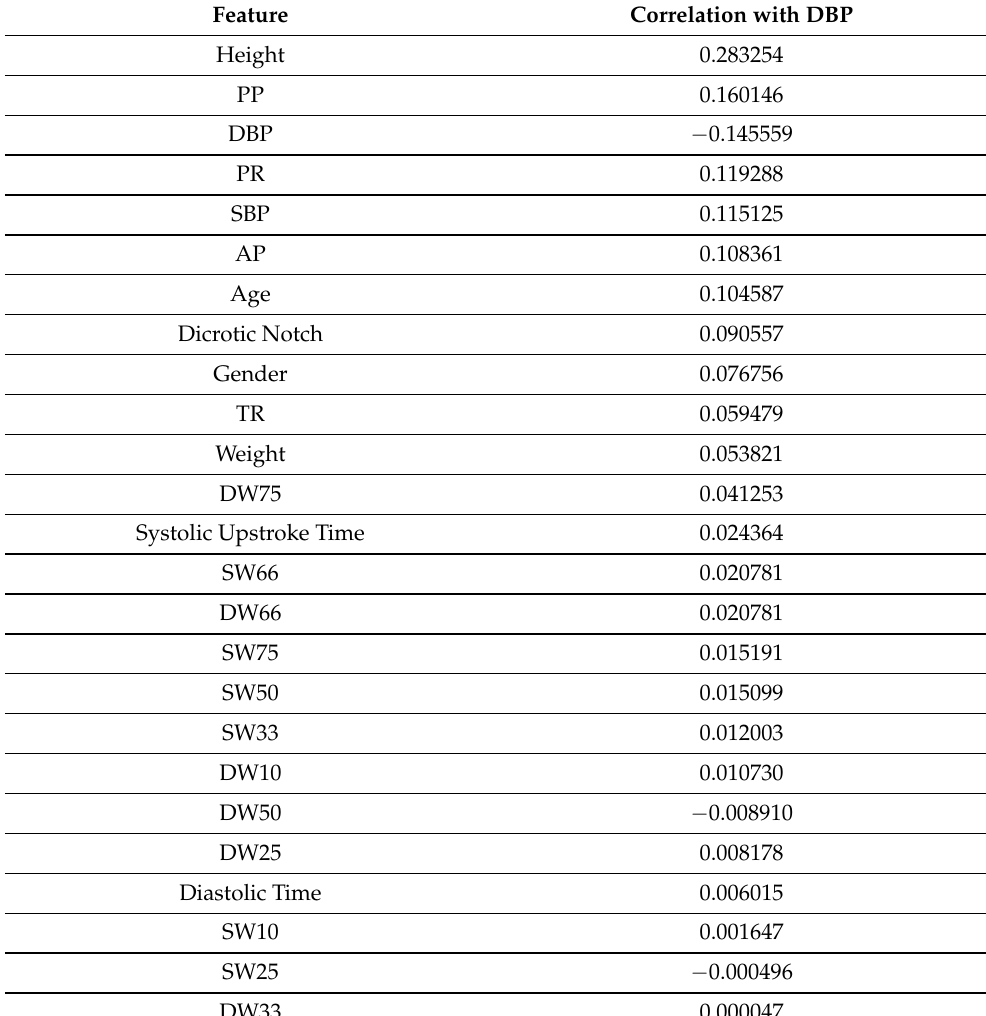
Table 10. Feature correlation for DBP